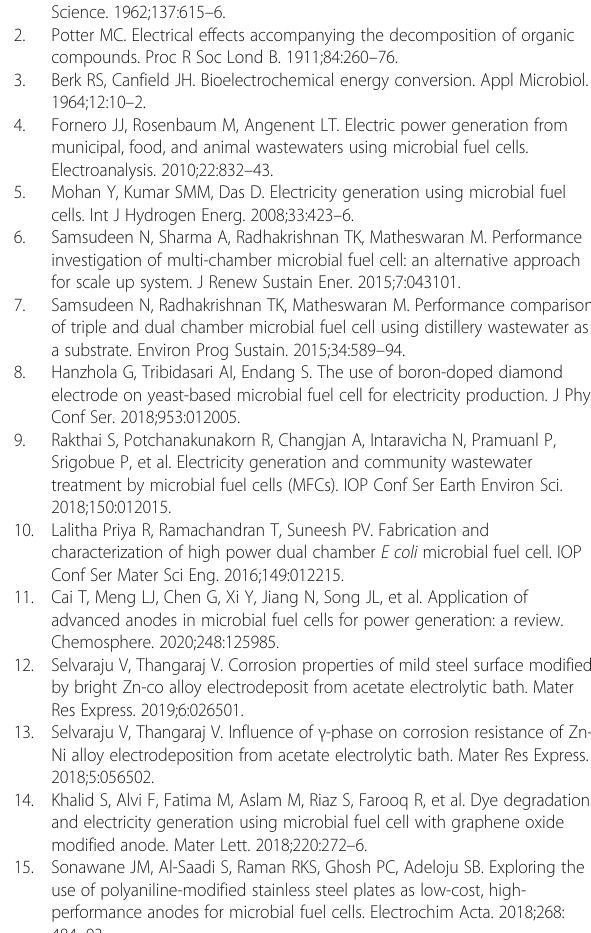
Additional file 1: Figure S1. Schematic diagram of DB-DCMFC. Figure S2. Block diagram of the process of MFC. Figure S3. Hardware setup of DB-DCMFC single